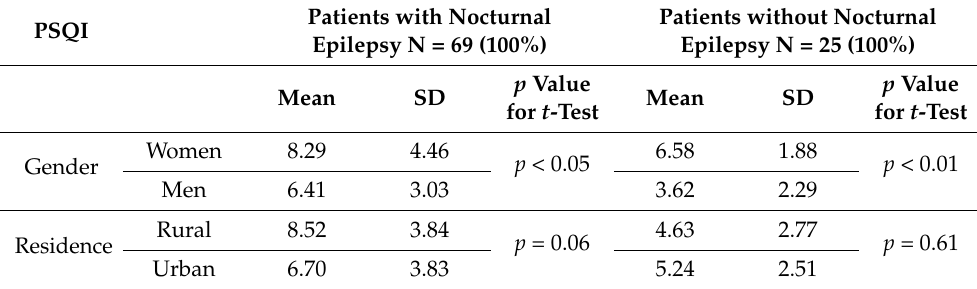
Table 4. PSQI scores depending on gender and demographical data.